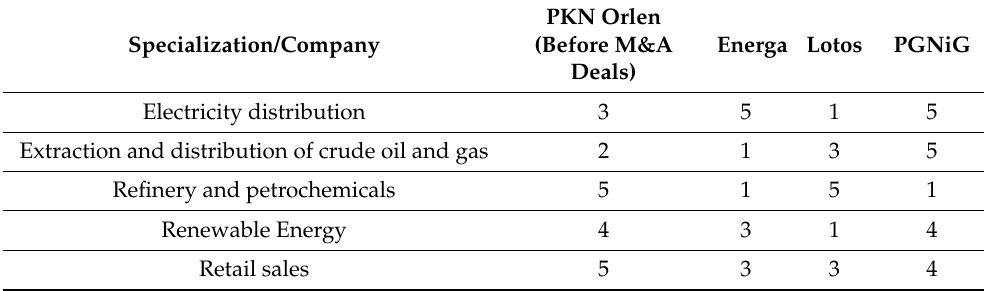
Table 8. Measurement of the diversification and integration degree of a multi-energy concern.